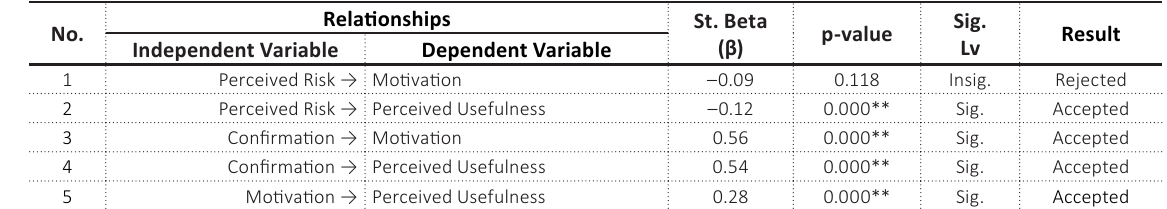
Table 4. Findings and hypotheses